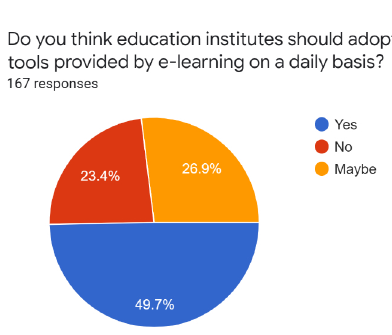
Fig. 3 Response to the question of whether e-learning methods should be adopted in daily classroom teaching.